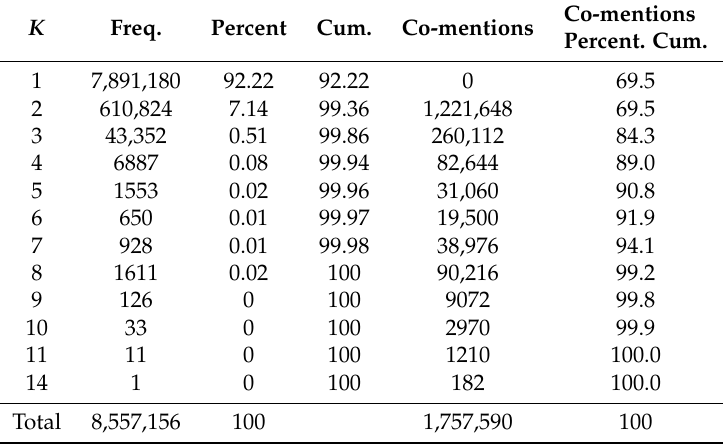
Table 2. The amount of news (Freq.) mentioning a given number of companies ( K ). K Freq.